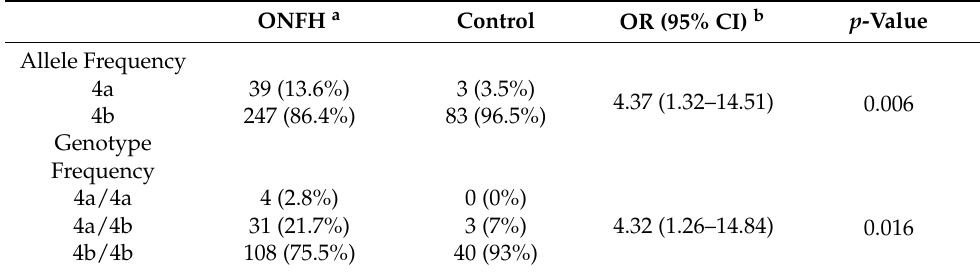
Table 1. NOS 27-bp repeat polymorphisms.